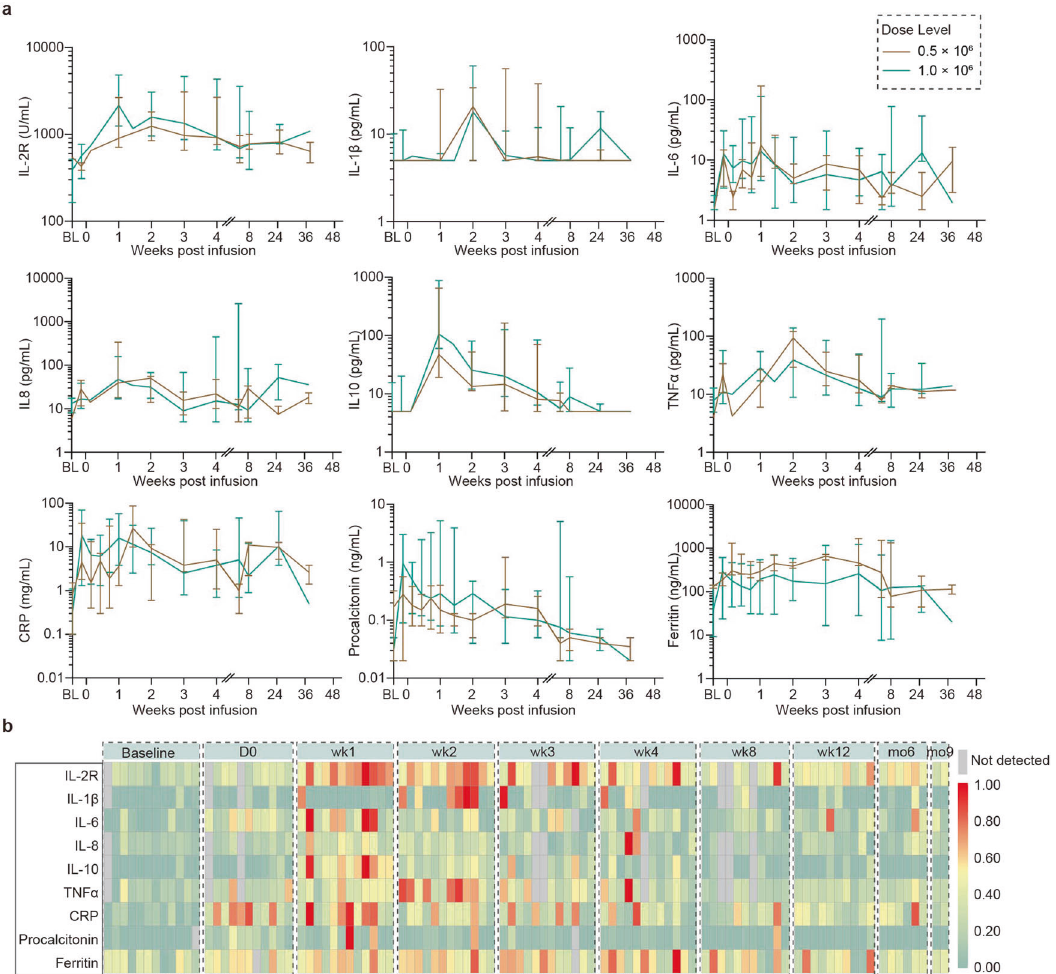
Fig. 5 Post ‑ infusion levels of cytokines. a Kinetic changes of post-infusion values of various cytokines in median according to dose group. Bars indicate 95% con fi dence intervals. b Post-infusion fold-changes of cytokine release. IL denotes interleukin. TNF denotes tumor necrosis factor. CRP denotes C-reactive